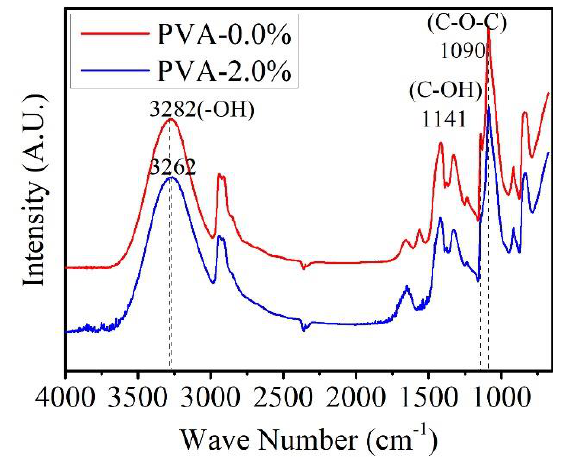
Figure 1. ATR-FTIR spectra of membranes of pure polyvinyl alcohol (PVA) and PVA with 2.0% of ferric ions.